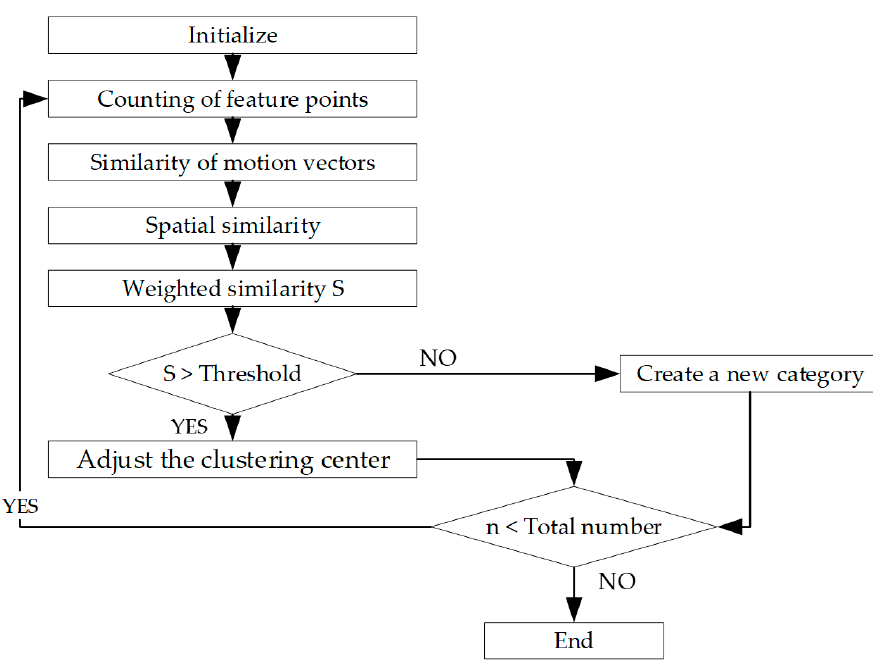
Figure 5. Flowchart of feature-point clustering based on motion vectors.